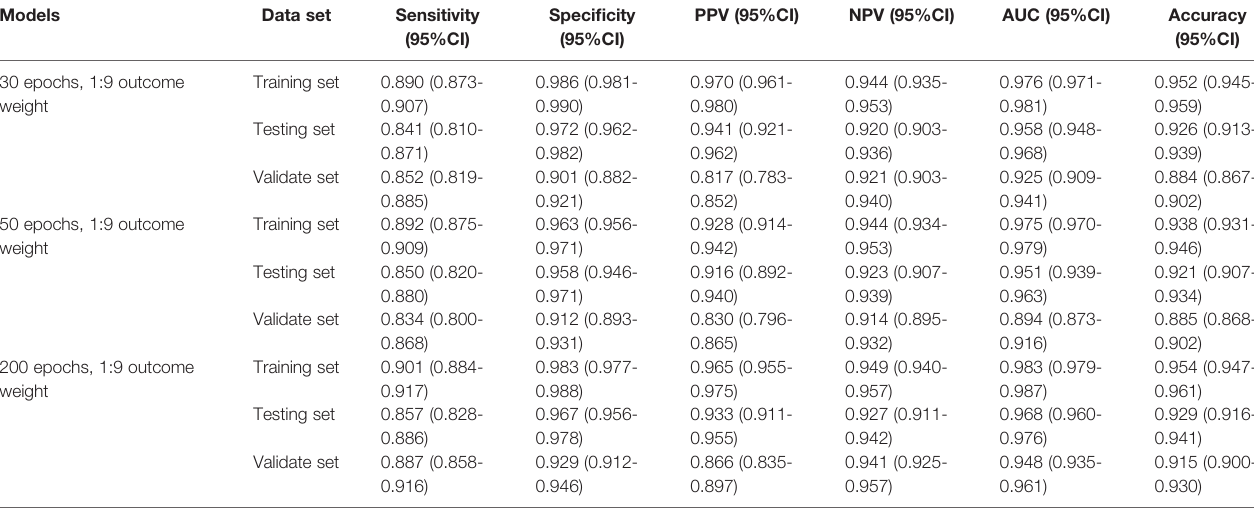
TABLE 4 | The performances of the AA, MDS, and AML three-classi fi cation model with different epochs. Models